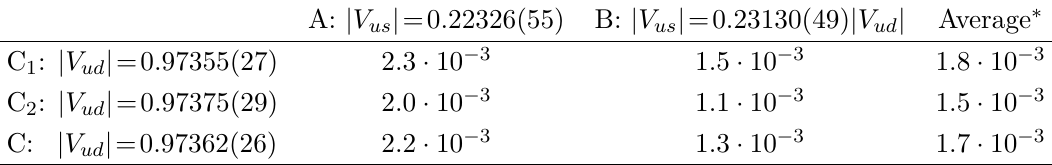
Table 2 . Values of δ CKM obtained for different choices of the values of | V us | and | V ud |